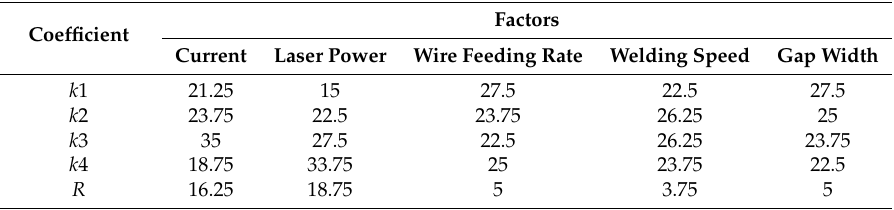
Table 6. Range analysis of welding quality score.